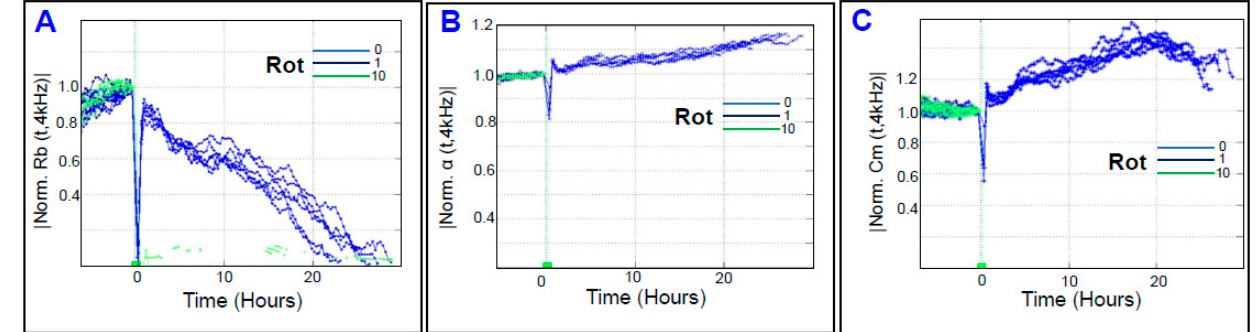
Figure 10. Real-time monitoring of human retinal endothelial cells’ α , Rb, and C m treated with electron transport chain (ETC) complex I inhibitor (rotenone, Rot) measured at 4000 Hz vs. time. ( A ) The curve of normalized R b , ( B ) the curve of normalized α , and ( C ) the curve of normalized C m .